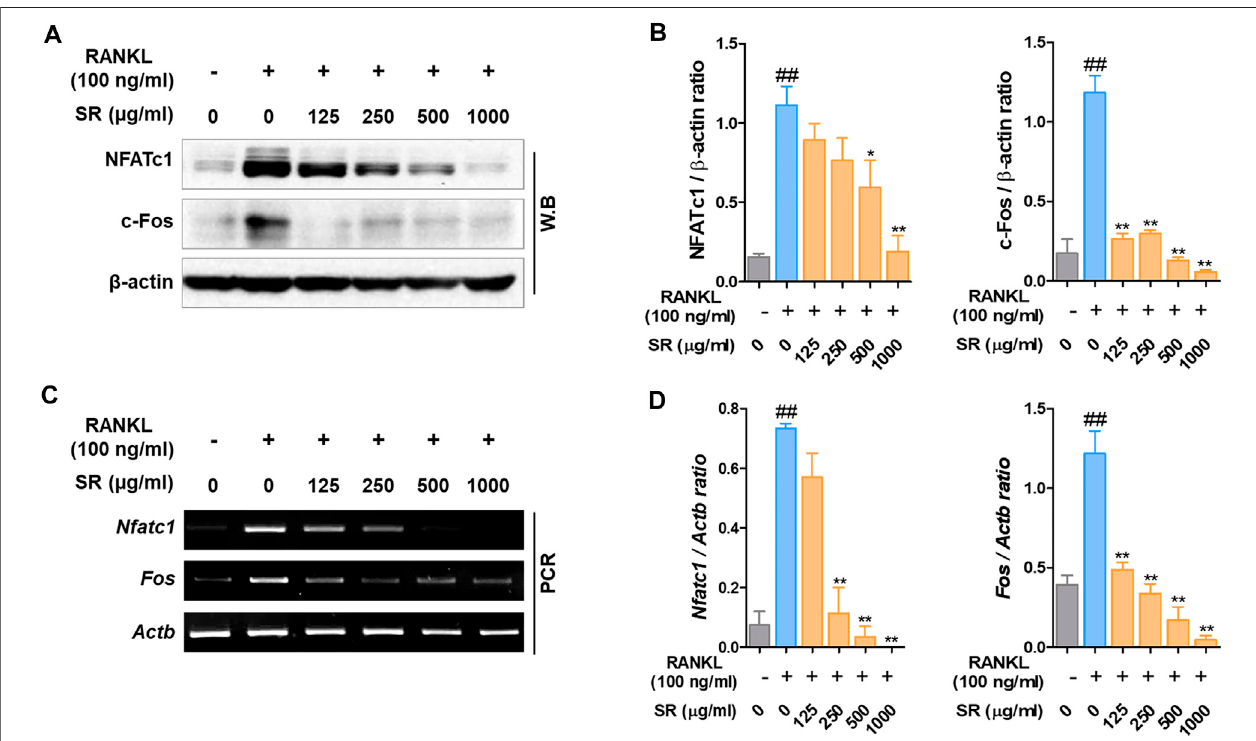
FIGURE 4 | The effects of SR on NFATc1 and c-Fos levels in RAW 264.7 cells. (A) Protein expression levels of NFATc1 and c-Fos were measured by western blotting. (B) The bands were normalized to that of β -actin, which was used as a loading control. (C) mRNA expression levels in Nfatc1 and Fos were measured by RT- PCR. The bands were normalized to that of β -actin ( Actb ). Data are presented as the mean ± SD of three independent experiments. Statistical analysis was performed using one-way ANOVA followed by Dunnett ’ s post hoc test. ## p < 0.01 vs. the normal group (untreated cells); * p < 0.05, ** p < 0.01 vs. the RANKL only treatment